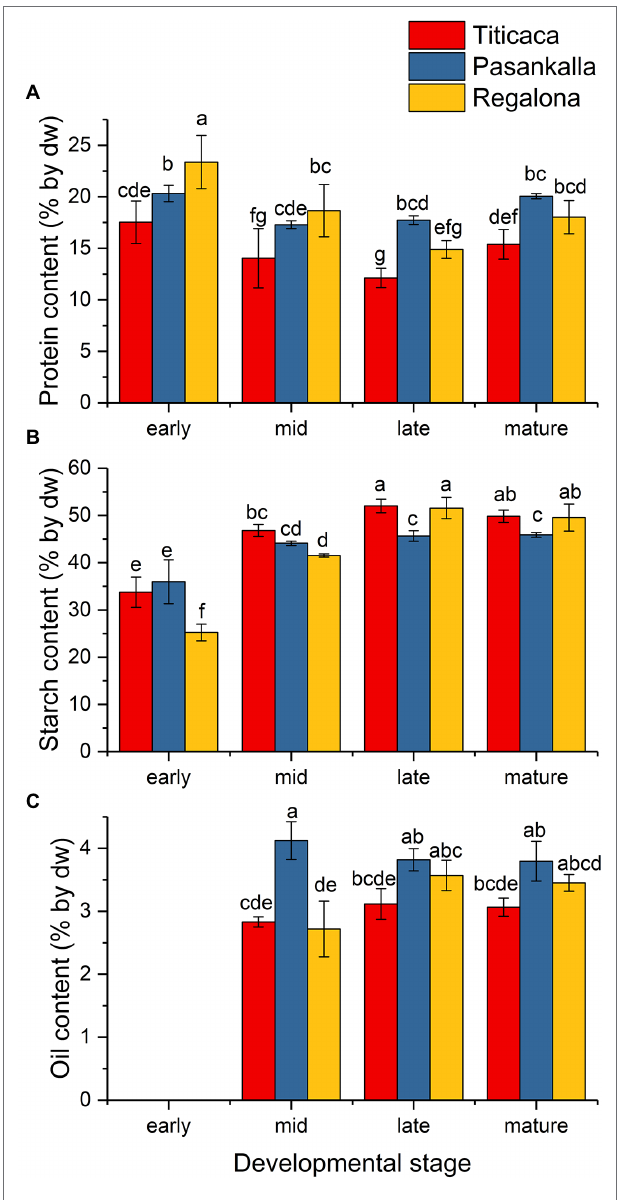
FIGURE 2 | Protein (A) , starch (B) , and oil (C) content [% by dry weight (dw)] in developing seeds of quinoa Titicaca, Pasankalla, and Regalona. The protein content in mature seeds of these genotypes was published previously (Gargiulo et al., 2019). Plants were grown under controlled growth conditions. For corresponding dpa for each developmental stage, see the text. Results are showing mean values ± SD of three biological replicates. Bars that do not share a letter are significantly different according to Fisher’s pairwise test ( p ≤